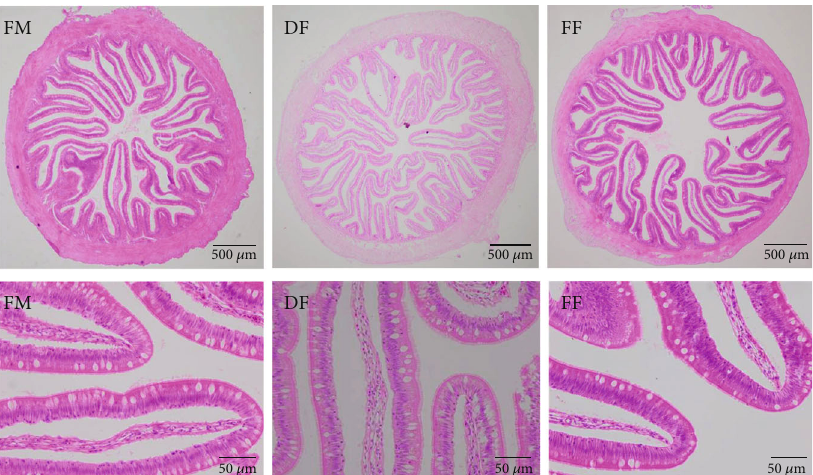
Figure 1: E ff ects of dietary di ff erent lipid content BSFL meal on the distal intestinal morphology in turbot. H&E staining. The intestinal tissue of all treatment groups was well formed without in fl ammatory cell in fi ltration.